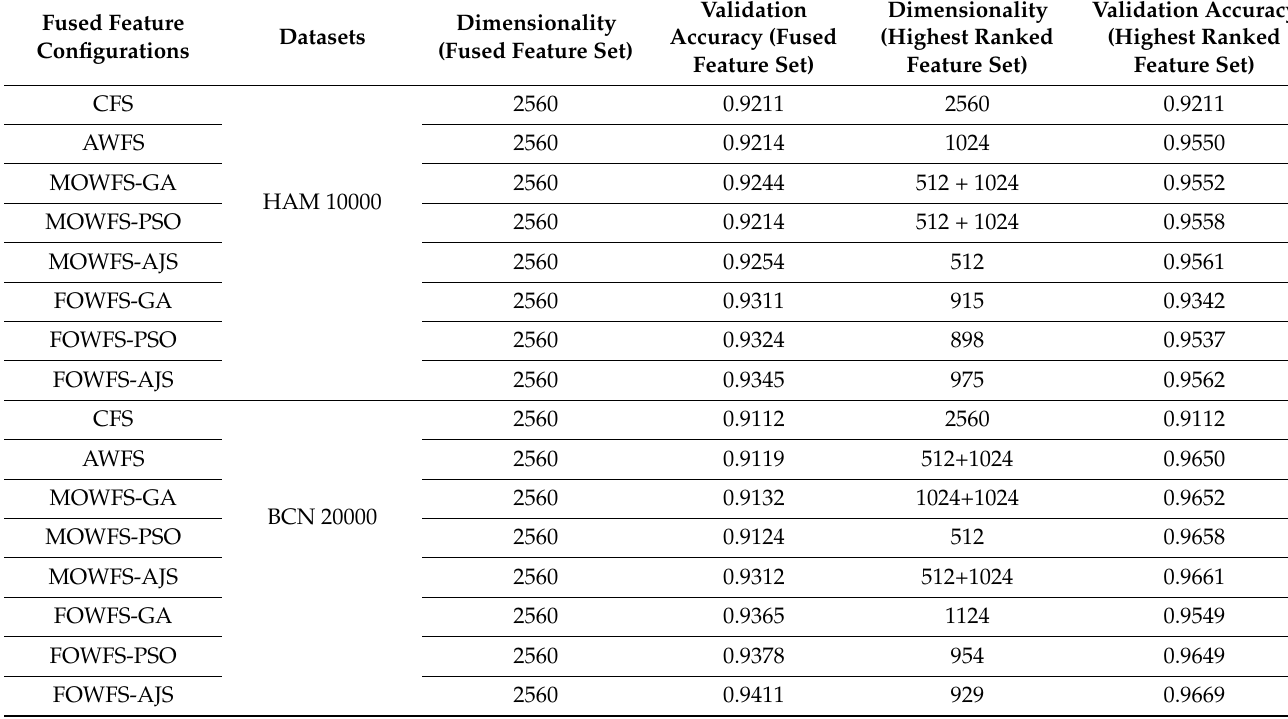
Table 6. Validation accuracy of fused feature sets vs. ranked feature sets based on MLP.